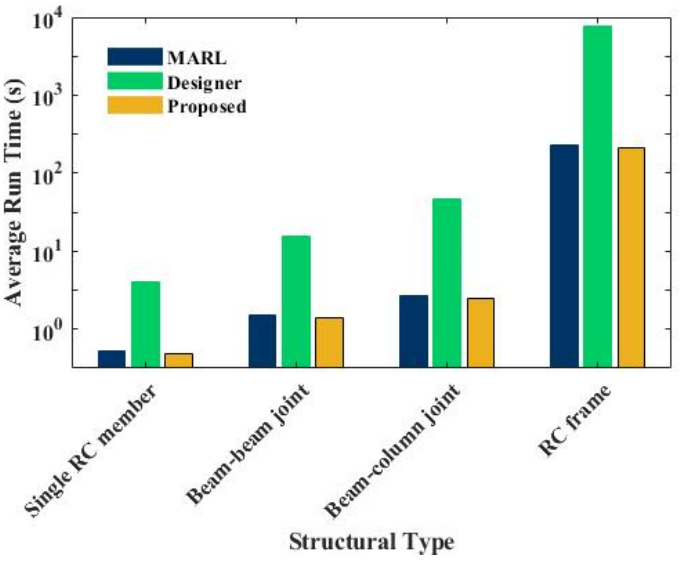
Figure 20. Performance graph of average run